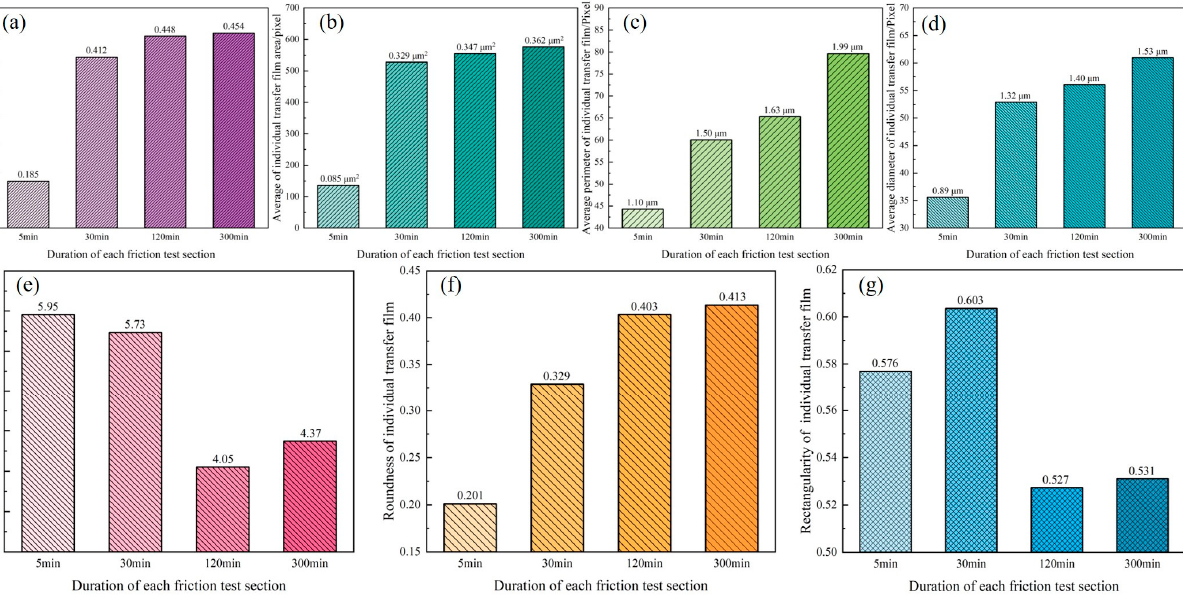
Figure 11. Geometry characteristics of transfer film. ( a ) coverage ratio; ( b ) area; ( c ) perimeter; ( d ) diameter; ( e ) aspect ratio; ( f ) roundness; ( g ) rectangularity.